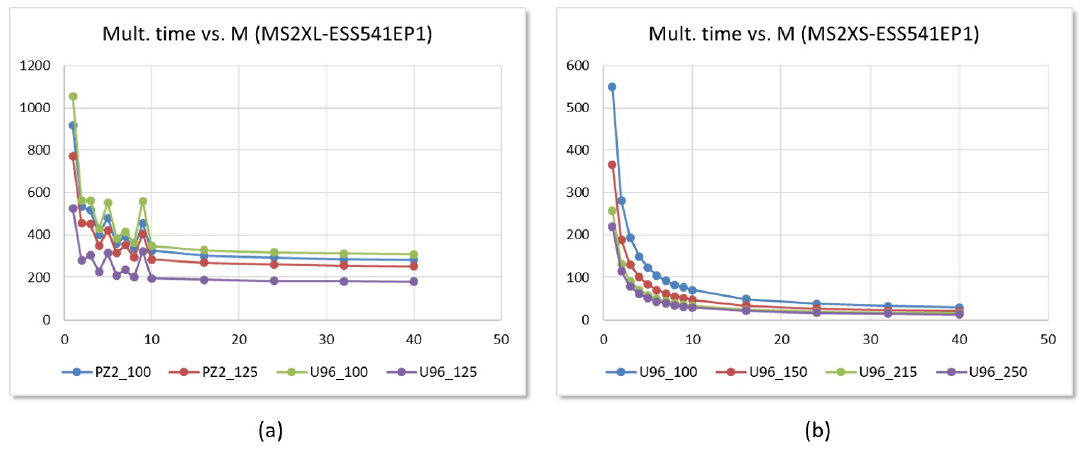
Figure 19. Comparison of multiplier operating times vs. M for: ( a ) MS2XL-based test systems implementing the parameter set EES541EP1 running at two clock frequencies on Pynq-Z2 and Ultra- 96 boards and ( b ) MS2XS-based test systems implementing the same parameter set on the Ultra-96 board running at different clock